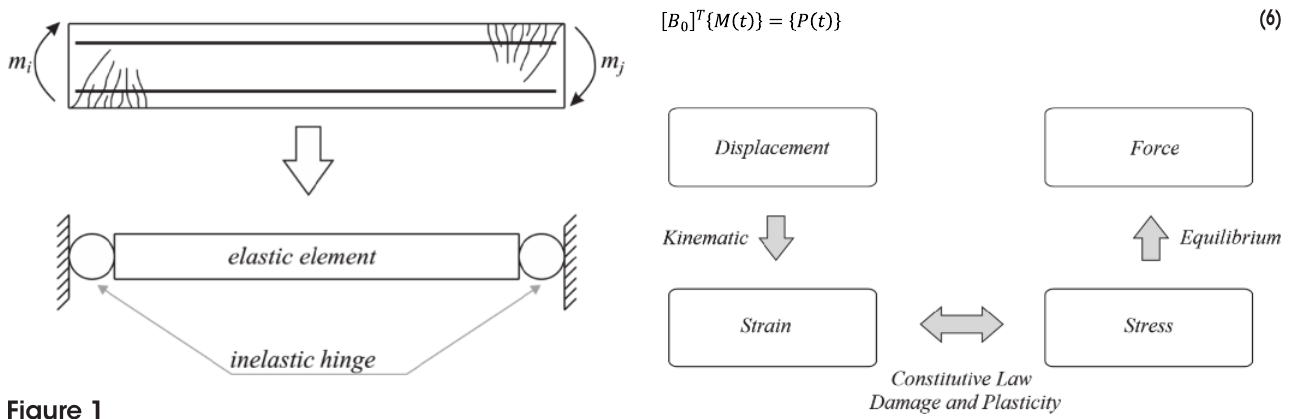
Figure 3 Flowchart for the lumped damage